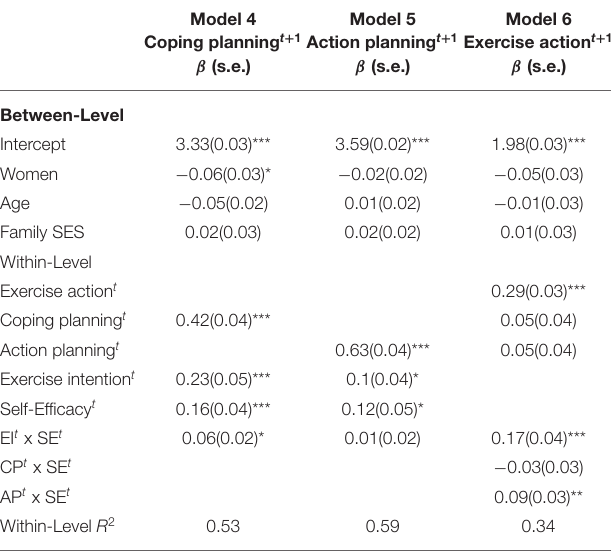
TABLE 3 | The results of multilevel moderation